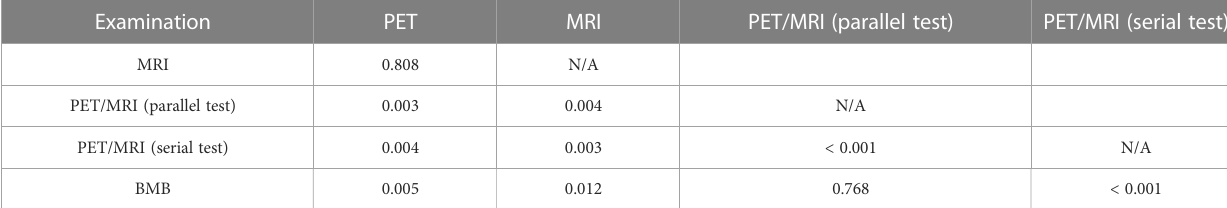
TABLE 4 Comparison of AUCs of PET, MRI, PET/MRI, and BMB for detecting bone marrow involvement.